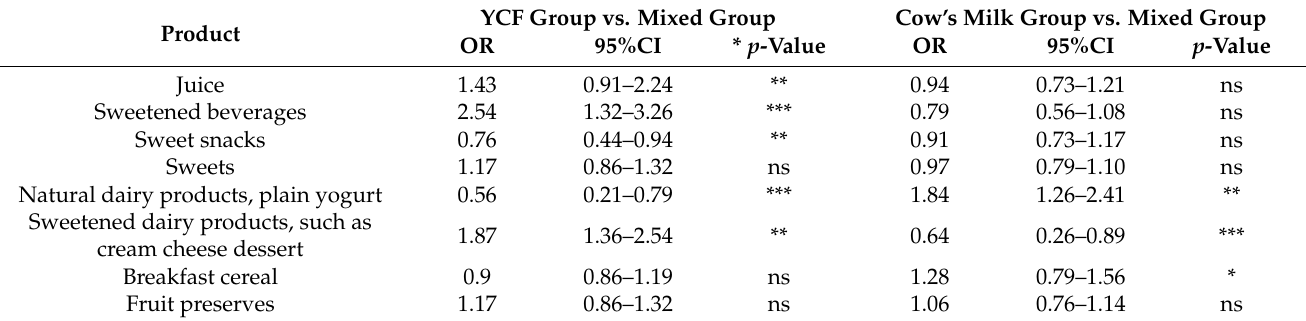
Table 6. Odds ratios (95% confidence interval). The associations between the type of consumed milk, YCF vs. cow’s milk, and the composition the diets of children aged 13–24